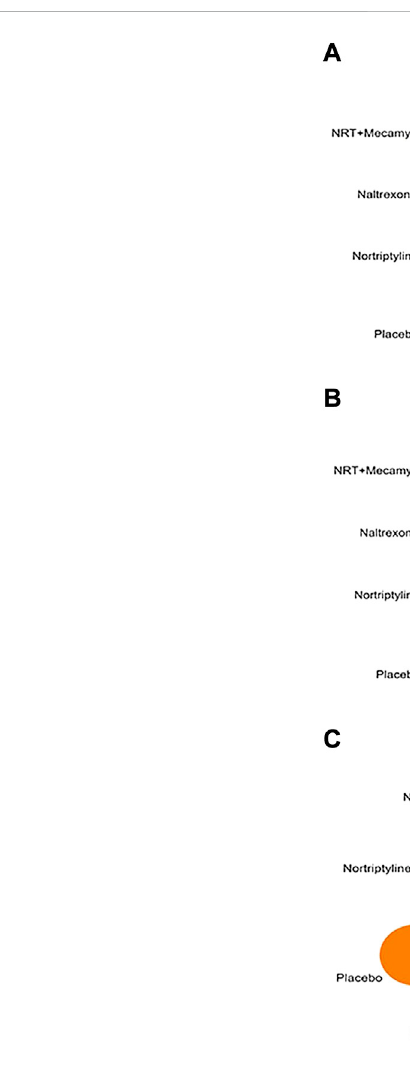
FIGURE 2 The network diagram for all interventions. (A) Overall abstinence rate; (B) Continuous abstinence rate; (C) 7-point continuous abstinence rate; NRT: Nicotine replacement